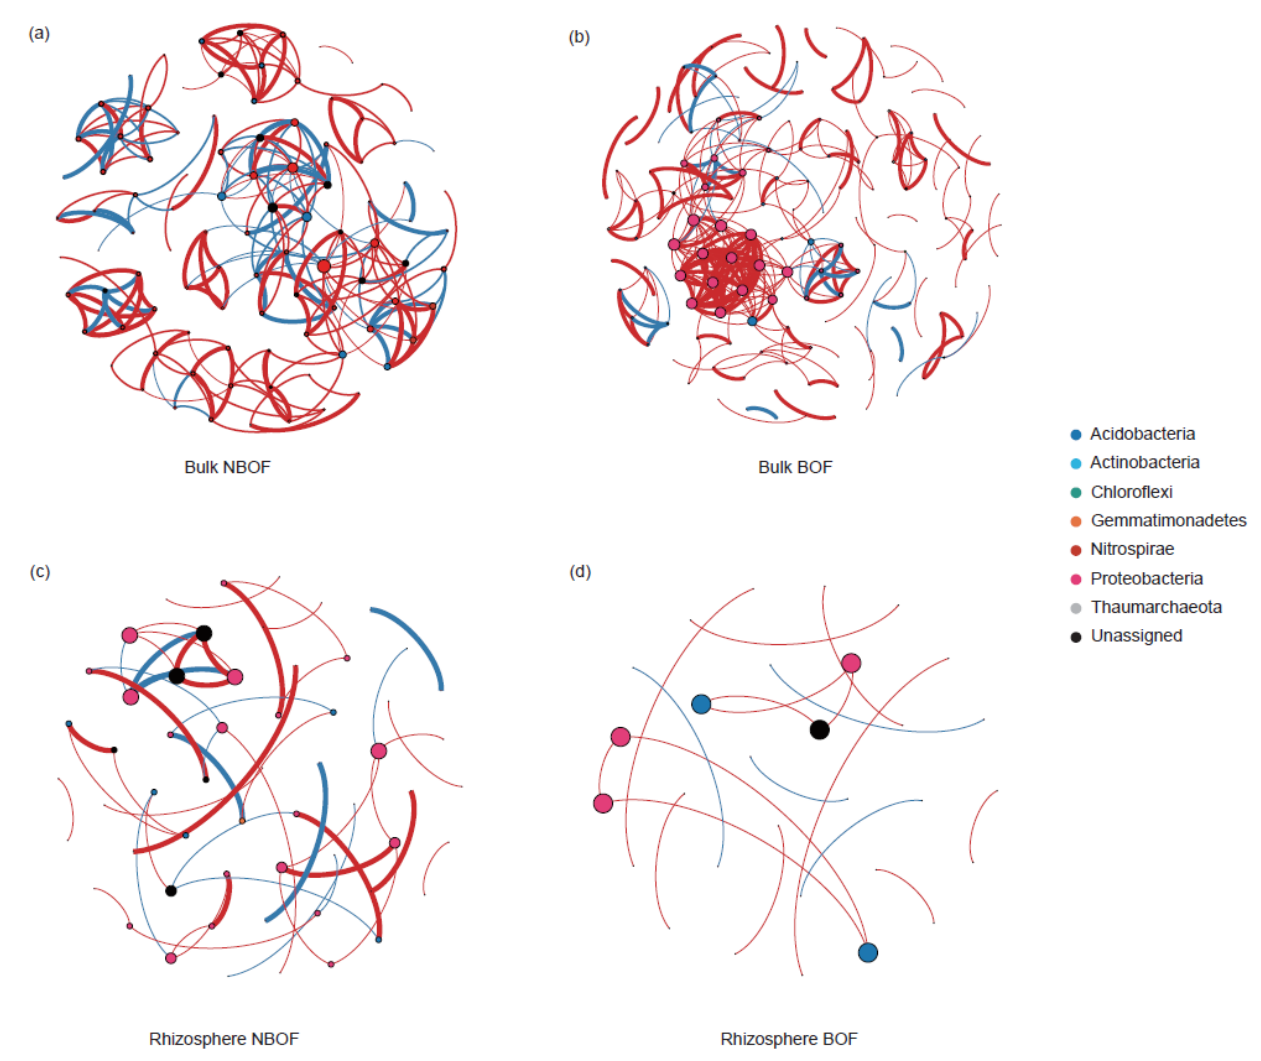
Figure 6. The bacterial co-occurrence networks in bulk soil of NBOF (( a ): CK and CF) and BOF (( b ): CFOF and OF) treatments, in rhizosphere soils of NBOF (( c ): CK and CF) and BOF (( d ): CFOF and OF) treatments. Node size is proportional to the betweenness centrality of each genus, and edge thickness is proportional to the weight of each correlation. The color of each edge represents positive and negative correlation coefficients: red represents positive correlation, and blue represents negative correlation. The thickness of each edge is proportional to the correlation coefficient ( p <